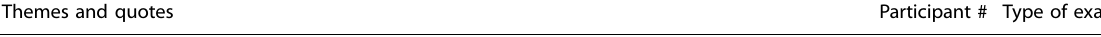
Table 2. Themes and corresponding exemplar quotes. Quote # Themes and quotes Participant # Type of